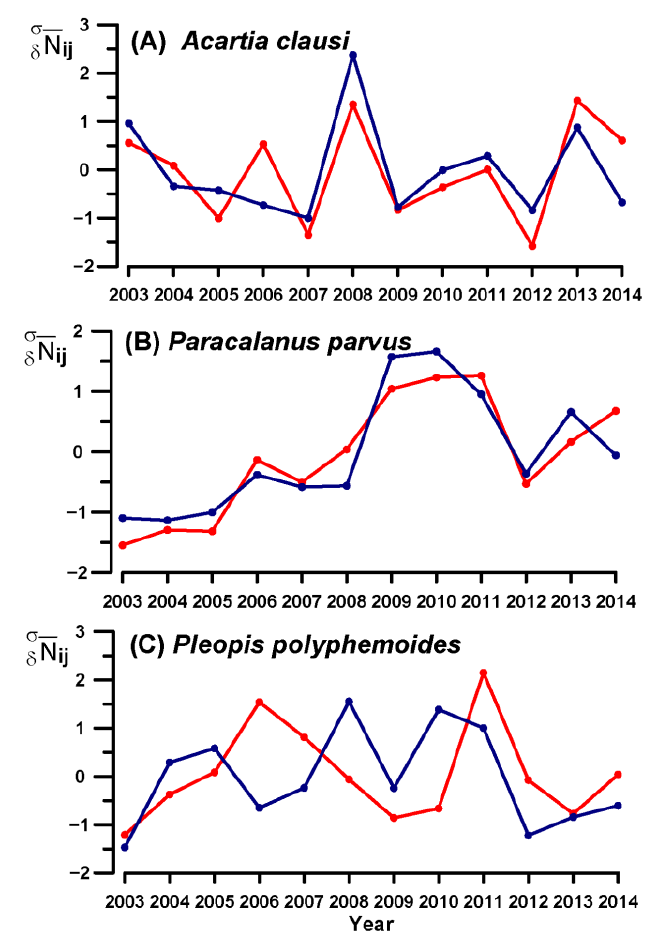
Figure 9. Pattern of interannual variability of abundance of eurythermal crustaceans in Sevastopol Bay at station 1 (blue) and station 2 (red) presented as normalized annual anomalies (see details of the method in Section 2.4): ( A ) — Acartia clausi ; ( B ) — Paracalanus parvus ; ( C ) — Pleopis polyphemoides .